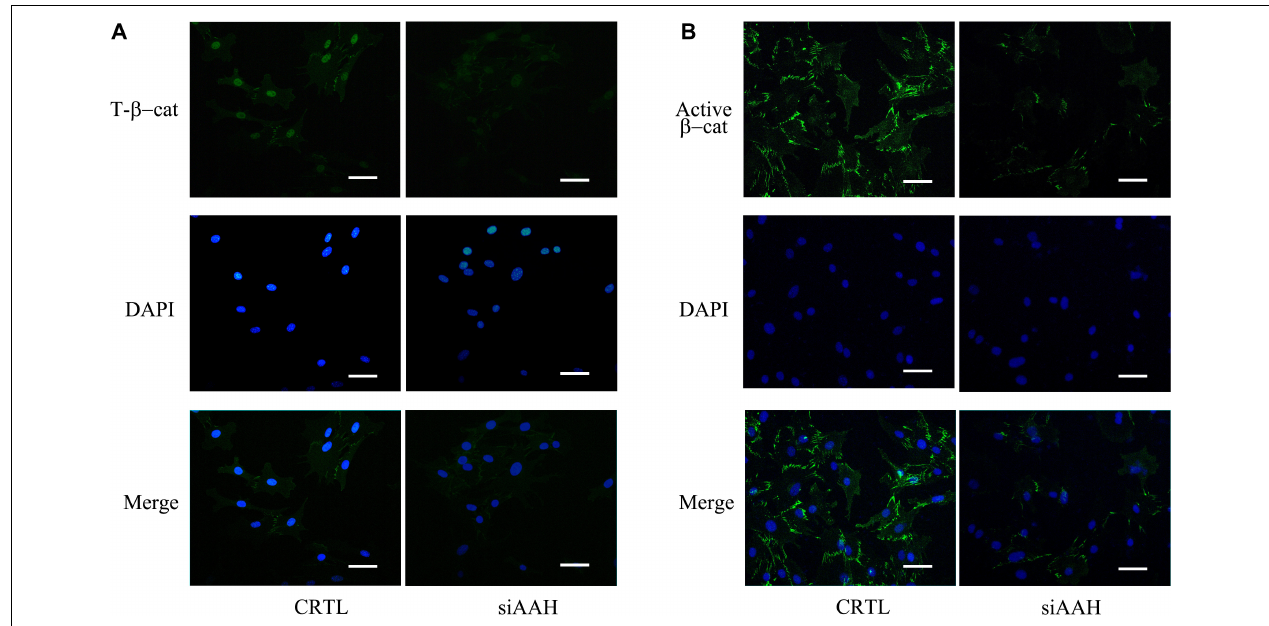
FIGURE 6 | Subcellular localization of total and active β -Catenin. (A) Subcellular localization of total β -Catenin protein in BMSCs transfected with Asph siRNA. Nuclei, DAPI (blue), total β -Catenin (green). (B) Subcellular localization of active β -Catenin [Non-phosph- β -Catenin (Ser33/37/Thr41)] protein in BMSCs transfected with Asph siRNA. Nuclei, DAPI (blue), active β -Catenin (green). Scale bar, 250 µ m.